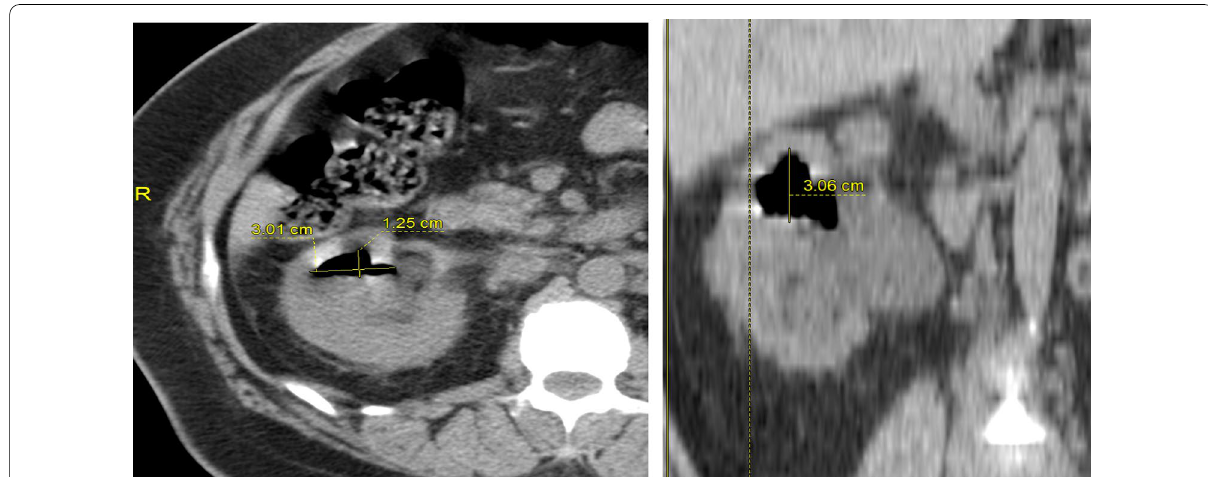
Fig. 1 A 60‑years old female patient presented with fever and right loin pain. CT axial and coronal images demonstrate gas locules inside the right upper calyceal group, it measures 3.5 1.2 3.1 as regard greatest axial and cranio‑caudal dimensions with total air locules volume 7 cc 3 . The × × patient was managed with successful medical conservative therapy and discharged